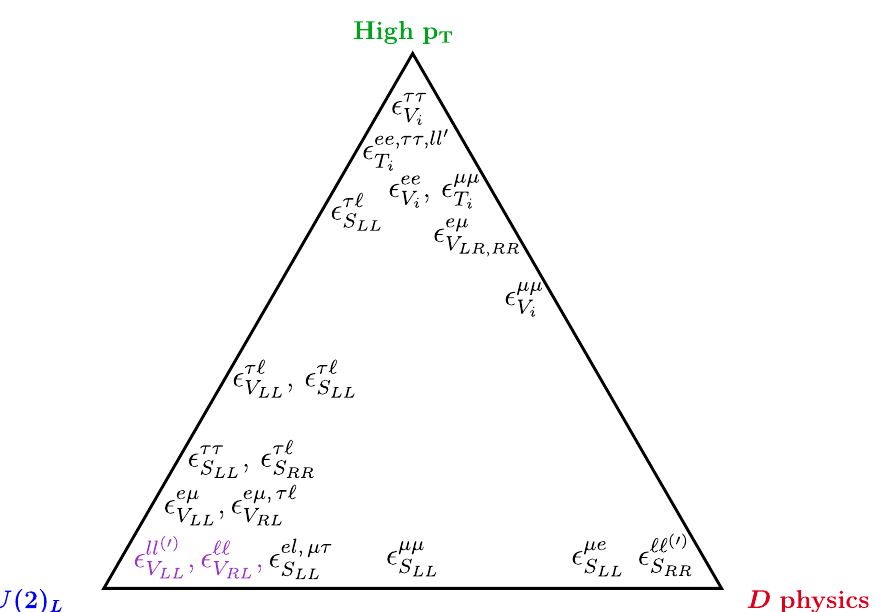
Figure 7 . Interplay between charm physics, high- p T , and SU(2) L relations for the neutral-current case ( ‘ = e, µ and l = e, µ, τ ). The proximity of the WCs to a particular vertex of the triangle is determined, approximately, by the relative strength of the corresponding constraints. In purple, those constraints that can be avoided by a particular flavor structure and/or WC